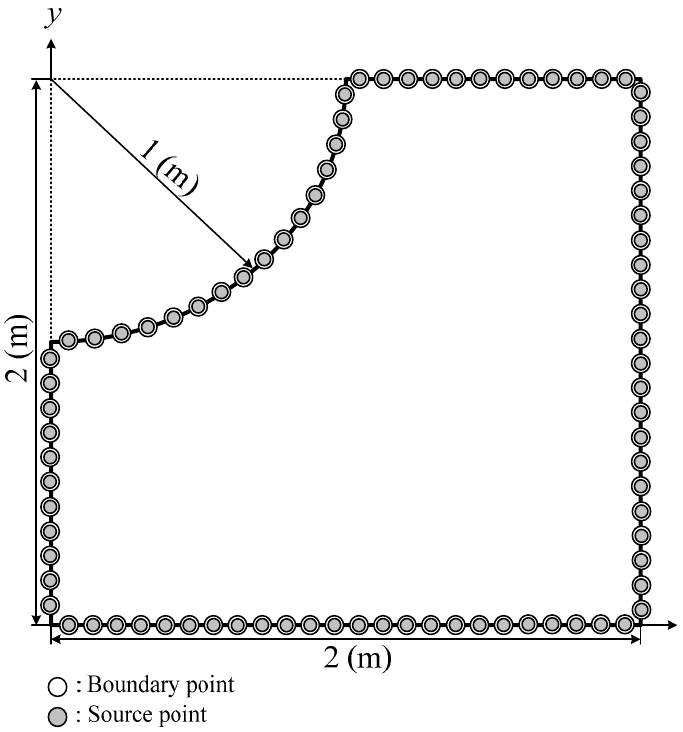
Figure 8. Illustration of the collocation points for boundary and source points.